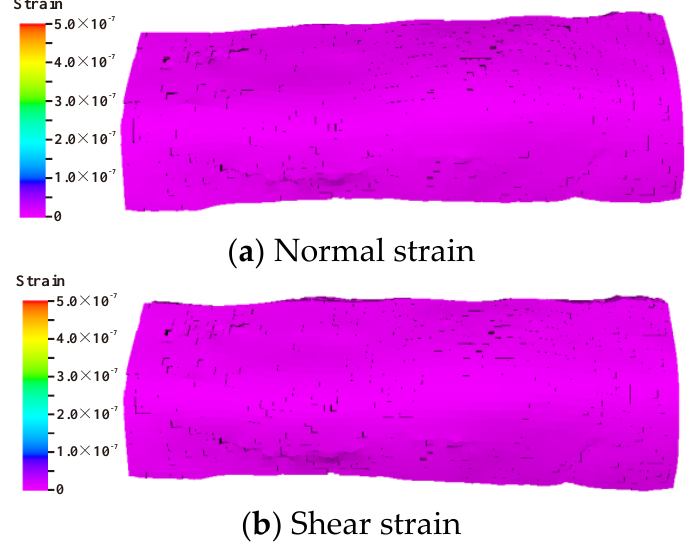
Figure 15. Plastic strain distribution of natural fractures in the target formation.